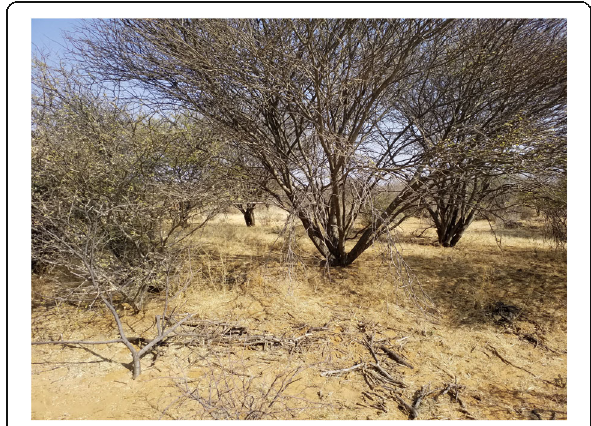
Fig. 3 Area close to the DTP in Ombooronde; photographed